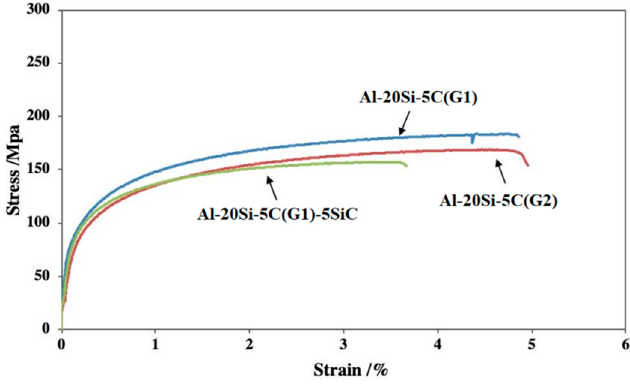
Figure 7. Tensile stress-strain curves of Al-20Si-5C(G1), Al-20Si-5C(G2), and Al-20Si-5C(G1)-5SiC. The tensile stress-strain curves of Al-28Si-7C(G1), Al-28Si-7C(G2), and Al-28Si-